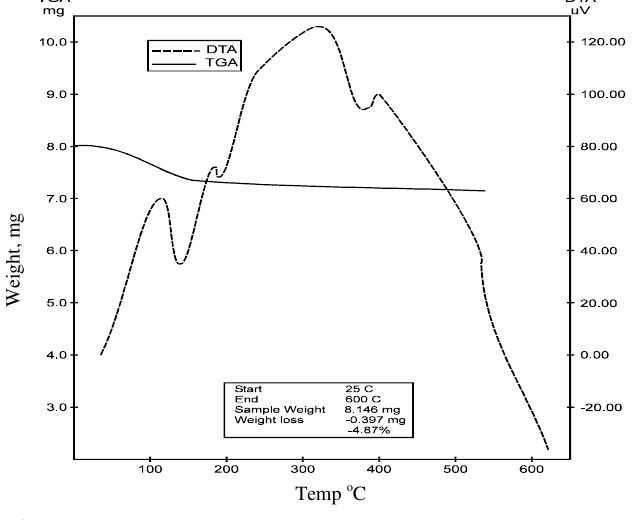
P) NH [WO(CN) 3 2 2